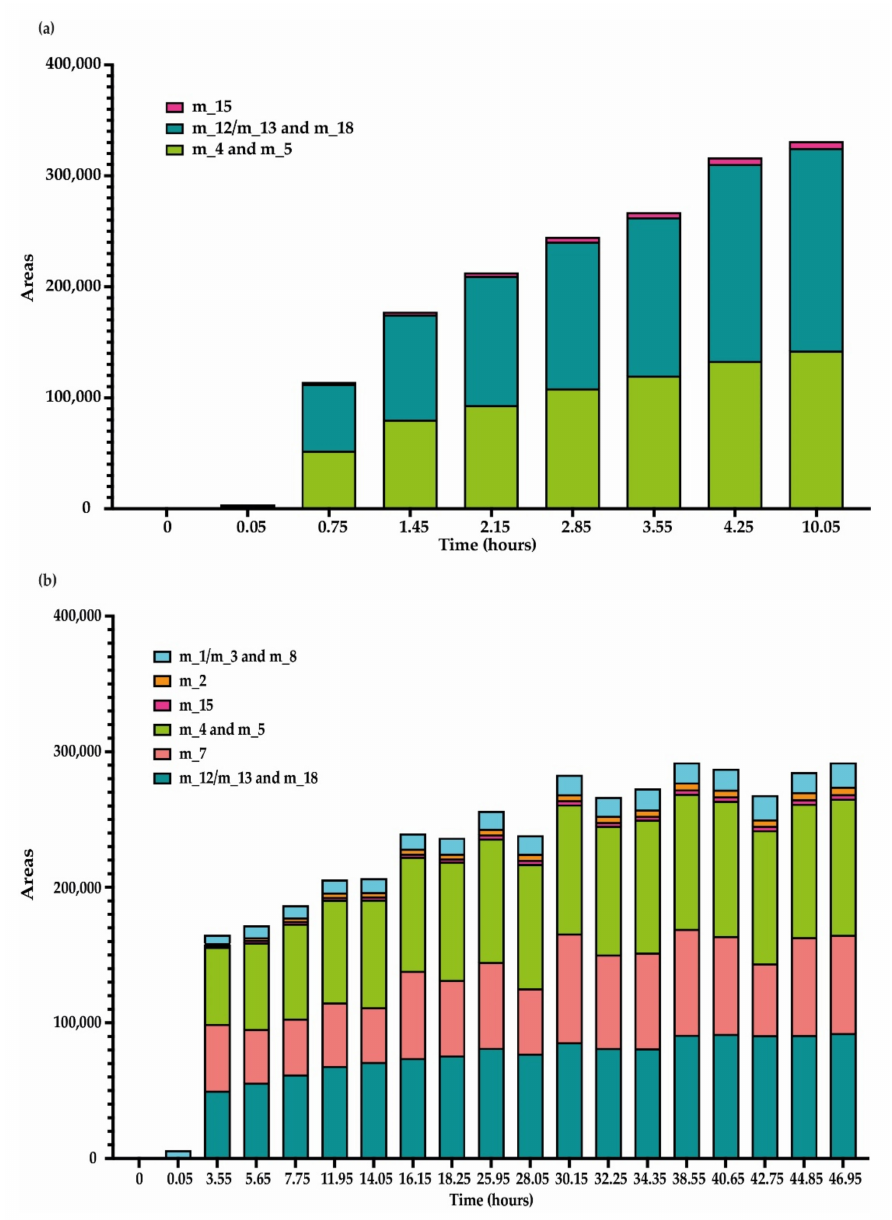
Figure 7. Putative metabolization products obtained during kinetic monitoring of trans -resveratrol (5 µ g/mL) metabolization in sodium acetate buffer by total extracellular protein extract from ( a ) D. seriata (200 µ g/mL) and ( b ) N. parvum (1 mg/mL). The mean was calculated over three biological replicates, each comprising two technical replicates ( n =